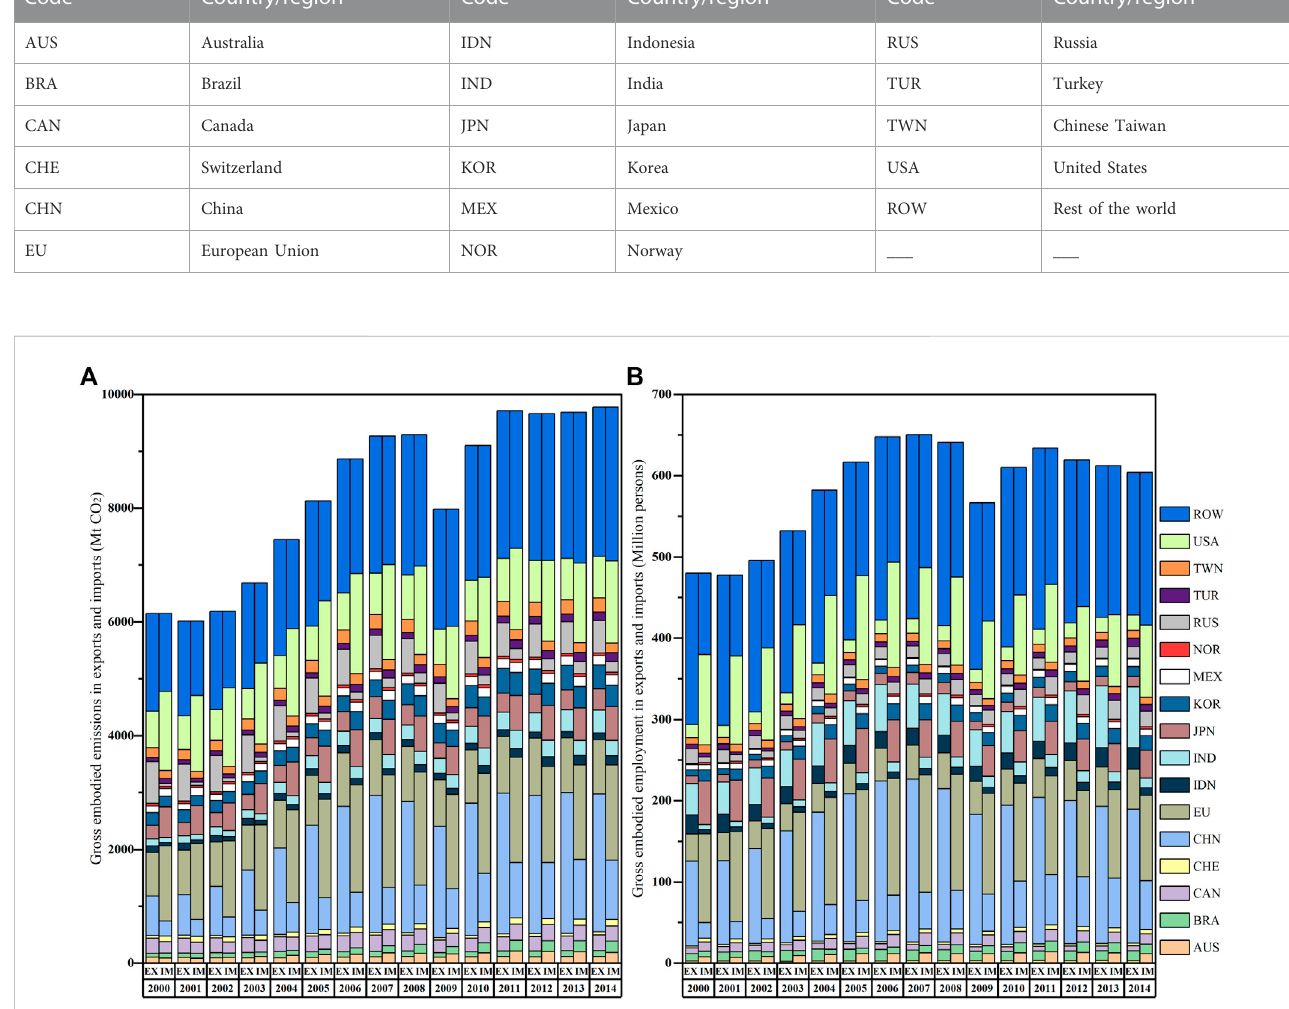
FIGURE 1 Gross embodied carbon emissions (A) and employment (B) in international trade Note: Abscissa label EX denotes exports and IM denotes